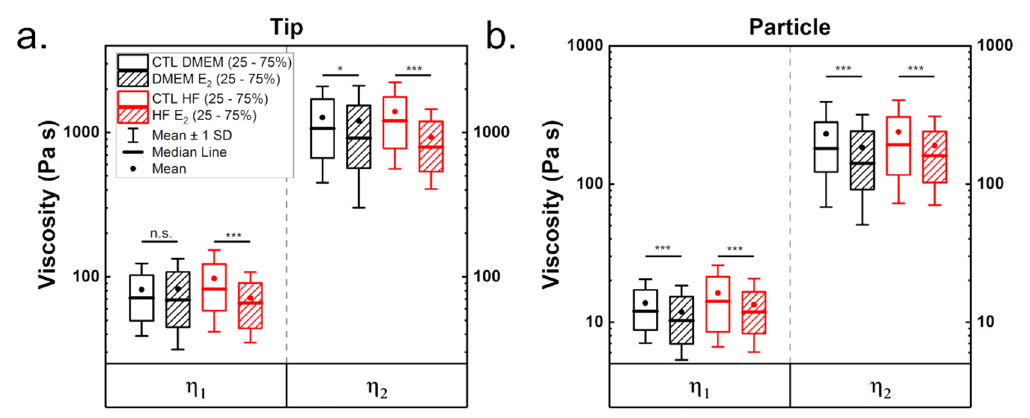
Figure 4. Viscosities determined from stress relaxation measurements when using a tip ( a ) or a particle ( b ) as an indenter. Equation (15) was used to calculate the shown values. Significances are reported as * for p < 0.05, and *** < 0.001.